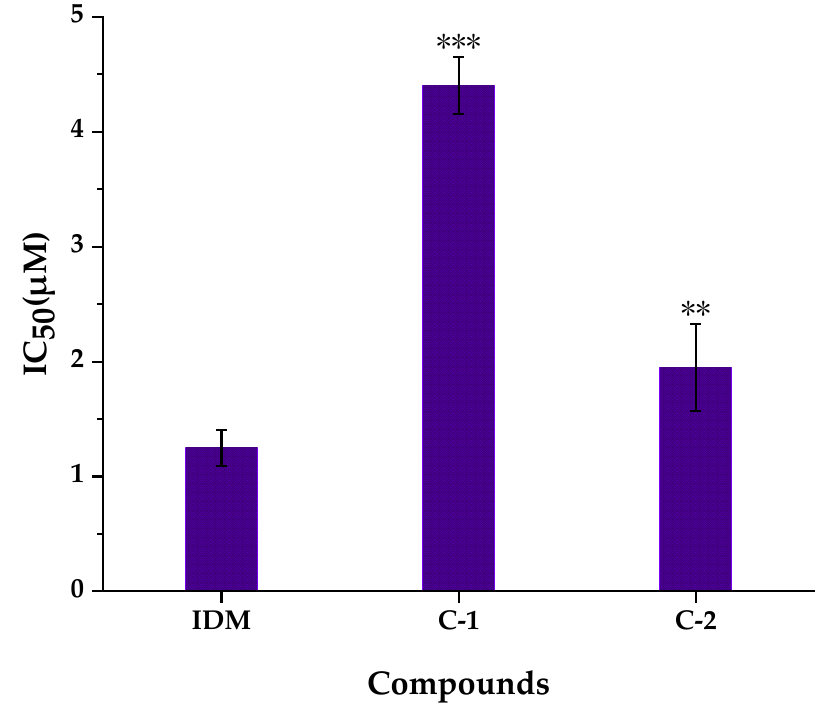
Figure 5. COX-2 inhibitory activities of compounds isolated from WE-P. IDM, Indomethacin; C-1, compound 1 ; C-2, compound 2 ; IC 50 : The half-maximal inhibitory concentrations. ** p < 0.01 and *** p < 0.001, compared with indomethacin group (IDM).